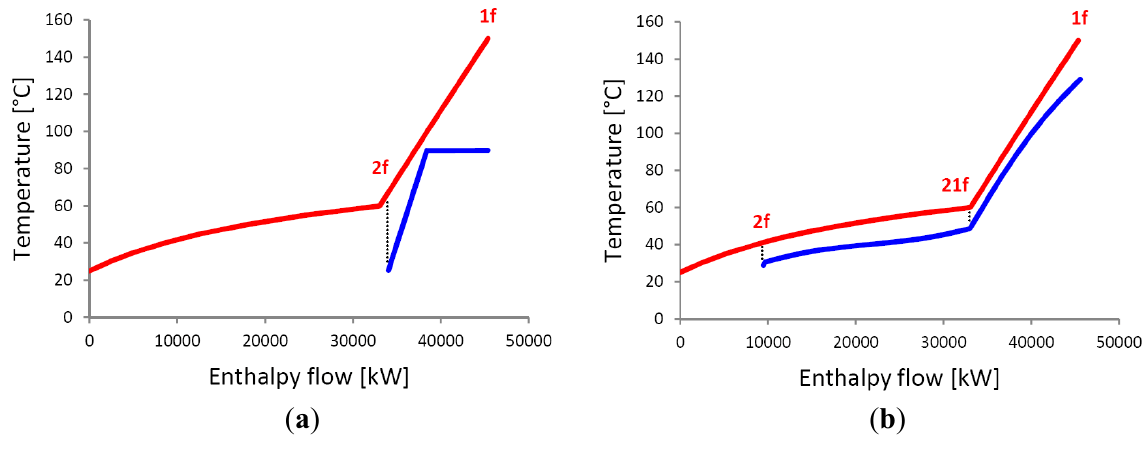
Table 3. Moist resource: cycle